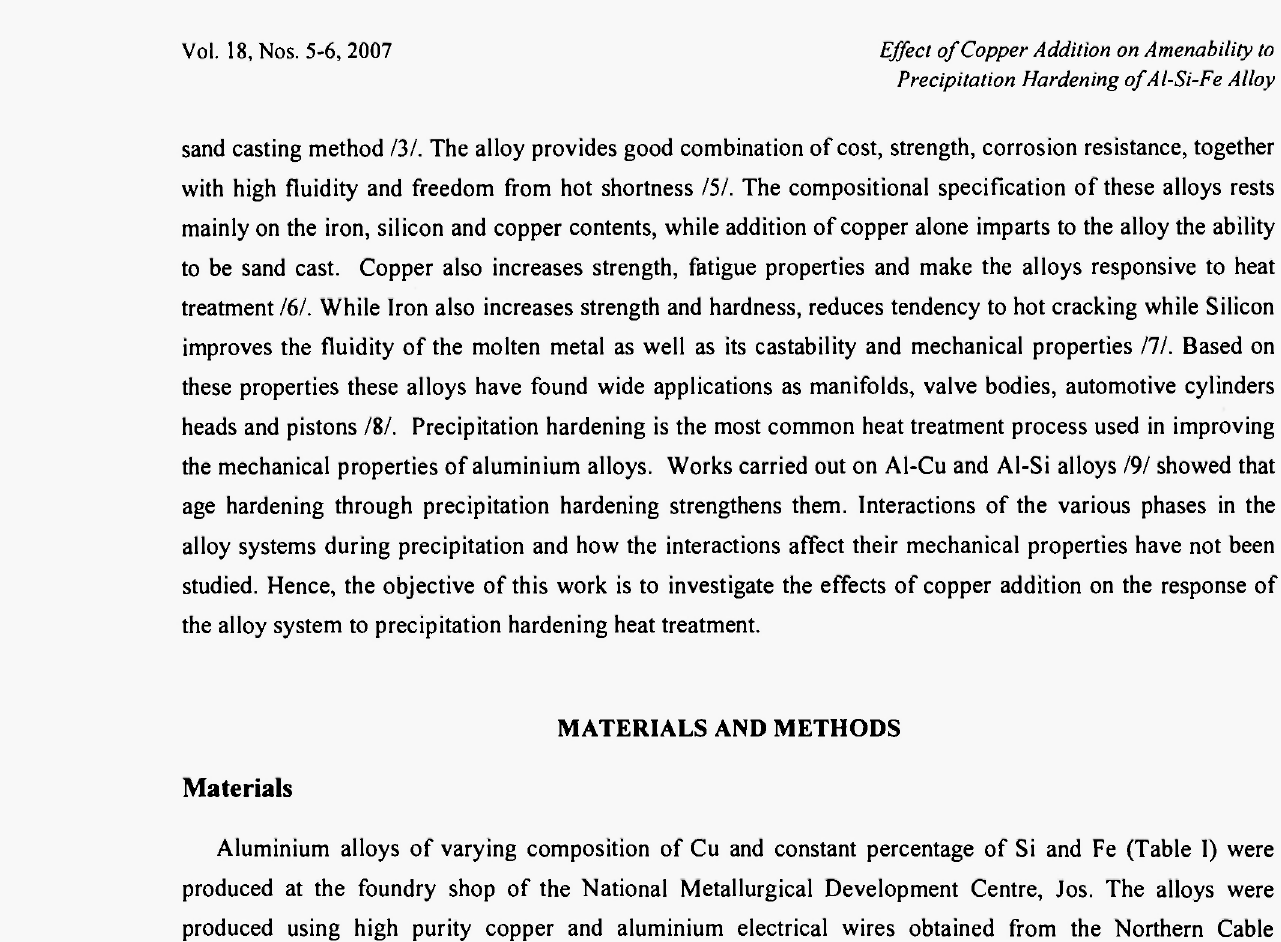
Composition of the As- Cast Alloy